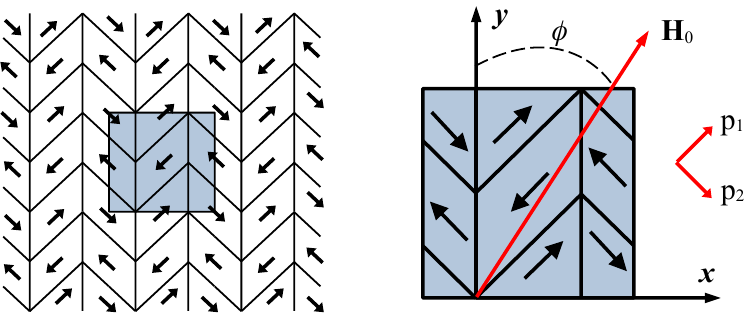
Figure 1. Computational domain for the twinned variant of